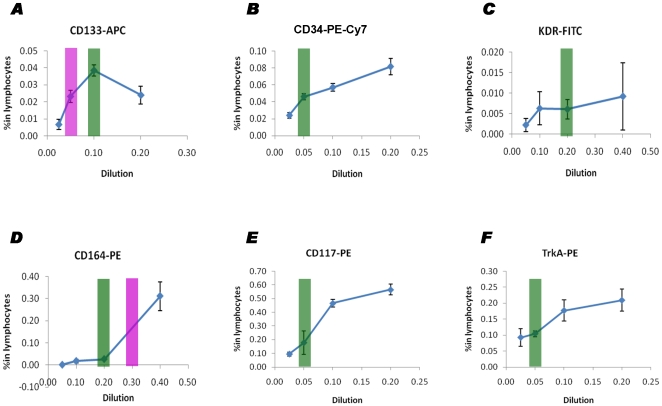
Titration of individual CPC markers before multicolour flow cytometry.Data are presented as geometric means with 95% confidence intervals. When without dilution, the volume of each antibody used for staining 100 µ0 of blood is: 10 µ0 of CD133-APC (50 CD133), 5 µL of CD34-PECy7 (50 µg/mL), 20 µL of KDR-FITC (50 µg/mL), 20 µL of CD164-PE (50 µg/mL), 5 µL of CD117-PE (50 µg/mL), and 20 µL of CD164-PE (25 µg/mL), respectively. The green bars show the dilution ratio of individual antibodies as recommended by vendors. The purple bars show the optimal dilution ratio of some antibodies according to our titration tests.